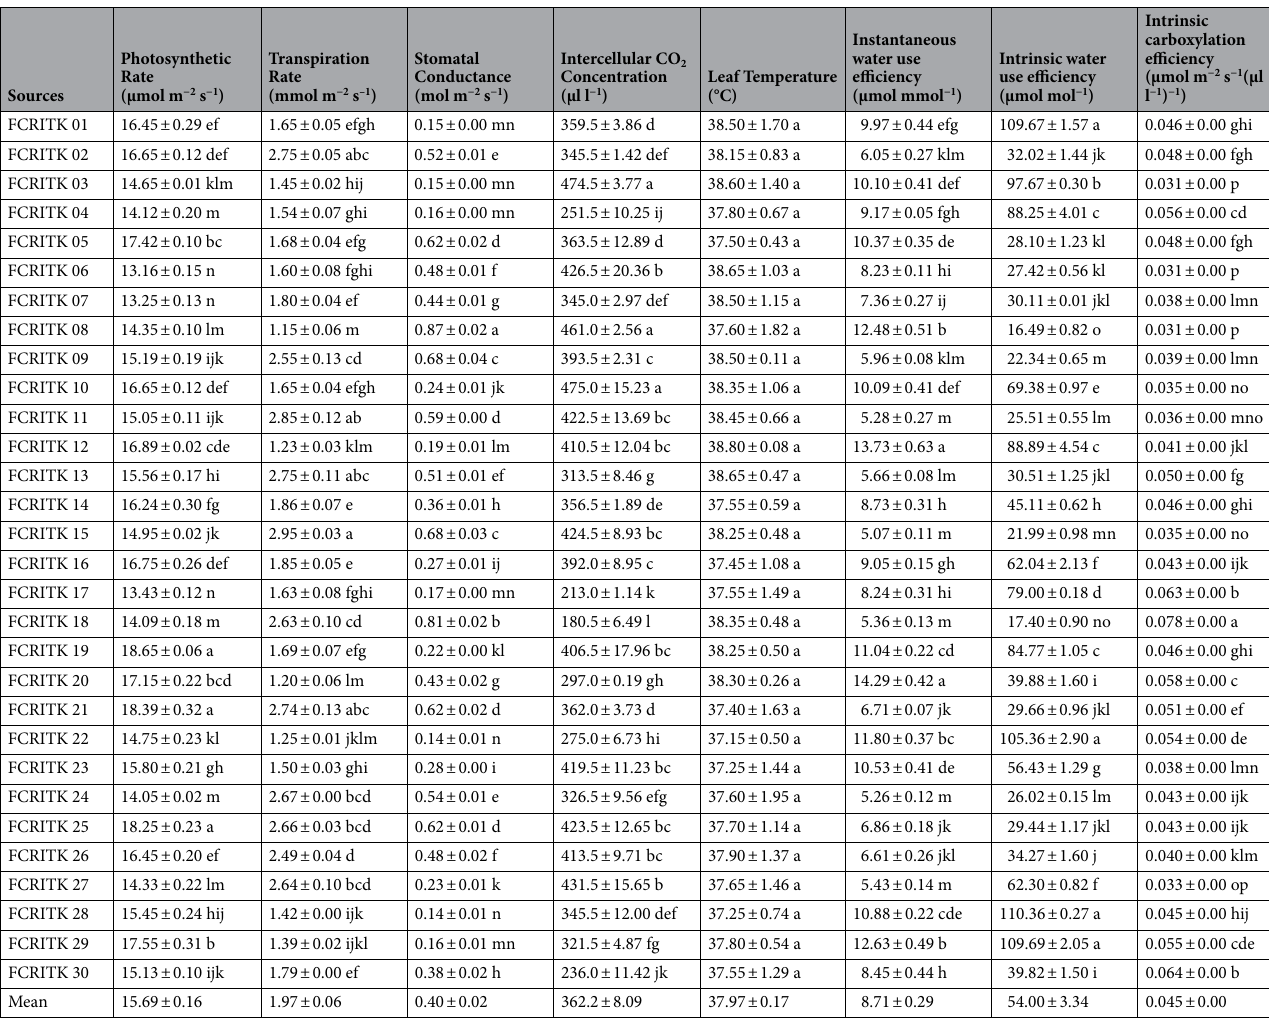
Table 5. Values of ecophysiological traits among teak seed sources from different states of India. Values followed by the different letter of each group were significantly different at p < 0.05 level of probability.